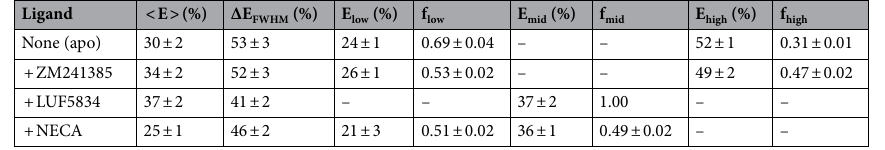
Table 1. Analysis of smFRET distributions of A 2A R bound to different orthosteric ligands. A 2A R(T119C- Q226C) labelled with AF488 and AF647 was measured without (apo) and with different ligands under saturating conditions (i.e., 100 μM). Mean (< E >) and width (full-width at half-maximum, ΔE FWHM ) of smFRET histograms, and the results of fitting (peaks E i and weights f i ) to a sum of Gaussians (Fig. 1). Standard deviations were estimated by statistical